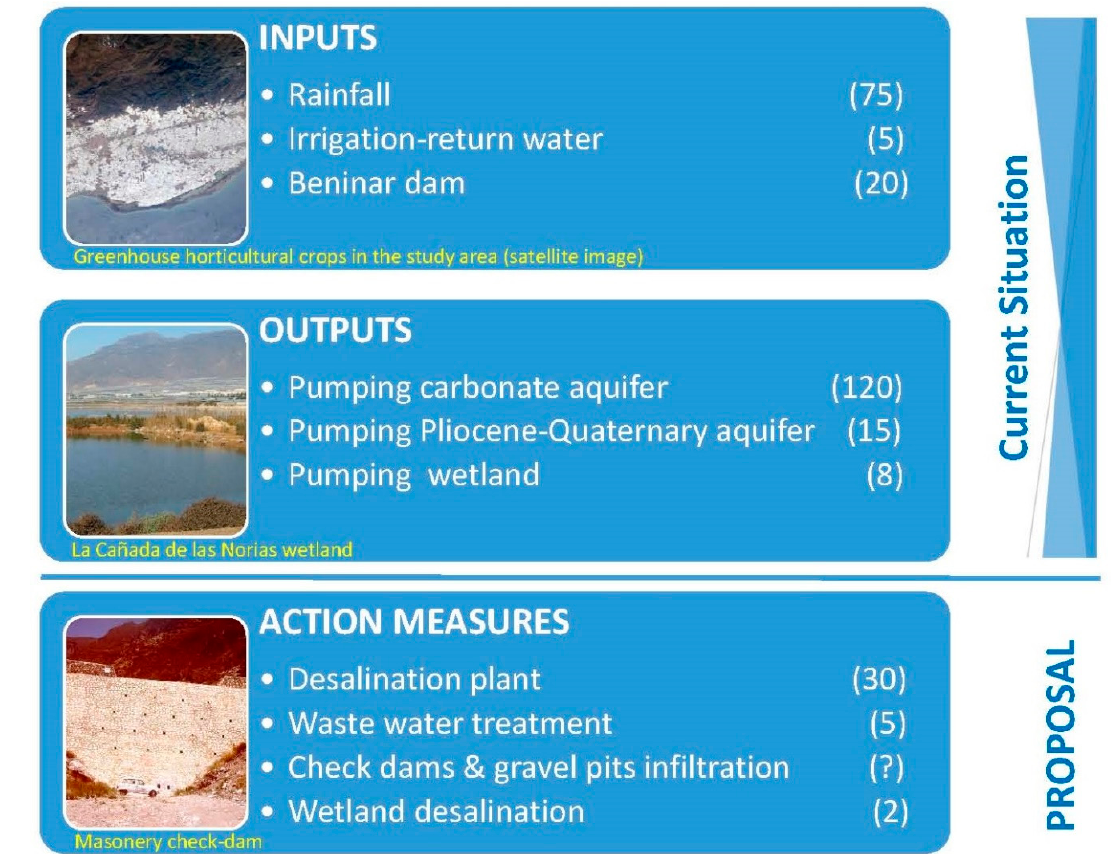
Figure 8. Current and future water management plan in the study area. The figures in brackets are the approximate values ·10 6 m 3 /year of the main parameters in the water budget.